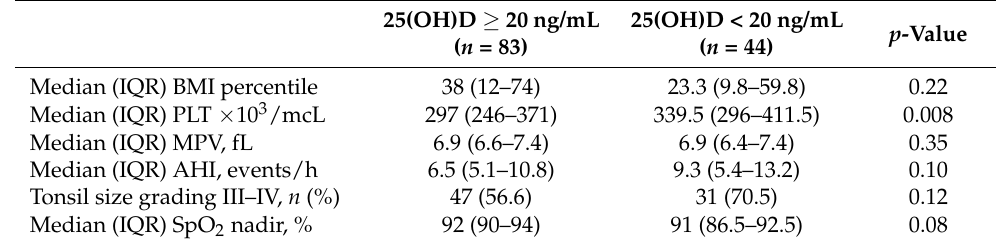
Table 3. Body Mass Index percentile, platelet count, Mean Platelet Volume, Apnea–Hypopnea Index, tonsil size grading, and SpO 2 nadir in OSAS patients with serum 25(OH)D levels <20 ng/mL and in OSAS patients with levels ≥ 20 ng/mL.